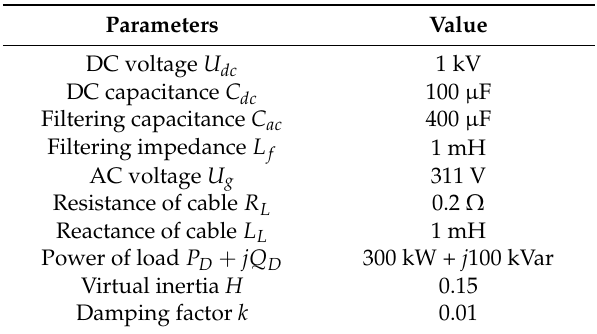
Table 2. Parameters of the VSG-IIDG and control